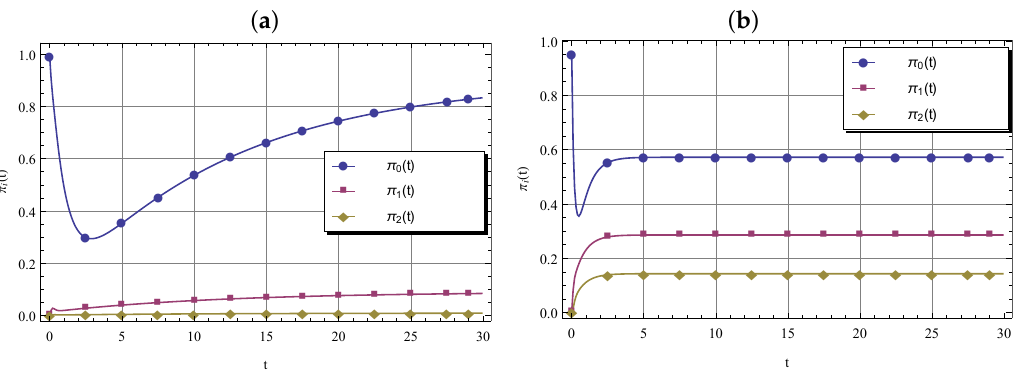
Figure 6. TDSSPs π i ( t ) , i = 0,1,2 for a = 1 ( a ) and for a = 0.2 ( b ).